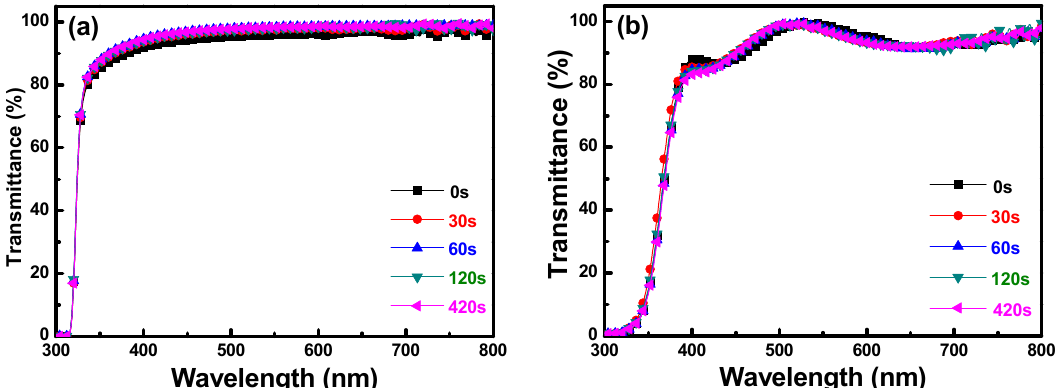
Figure 3. Transmittance spectra of ( a ) PI substrates and ( b ) FZO films on PI substrates as a function of O 2 plasma pretreatment time.